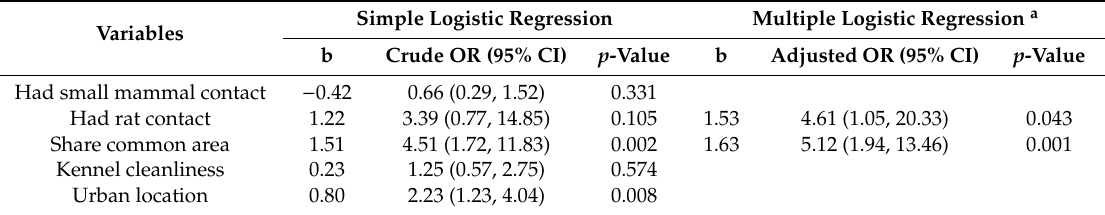
Table 2. Risk factor a ff ecting dogs’ leptospiral seropositivity from working dog and shelter dog